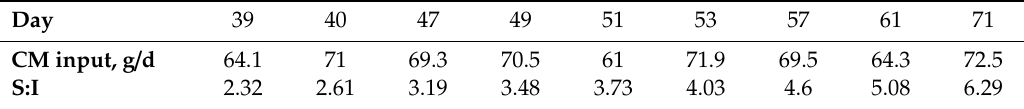
Figure 1. Experimental set-up: ( a ) different processing steps; ( b ) top view of the reactor Biostat ® A showing location of different ports and sensors. Table 1. Cattle manure (CM) feeding scheme with corresponding digester substrate to inoculum (S:I)